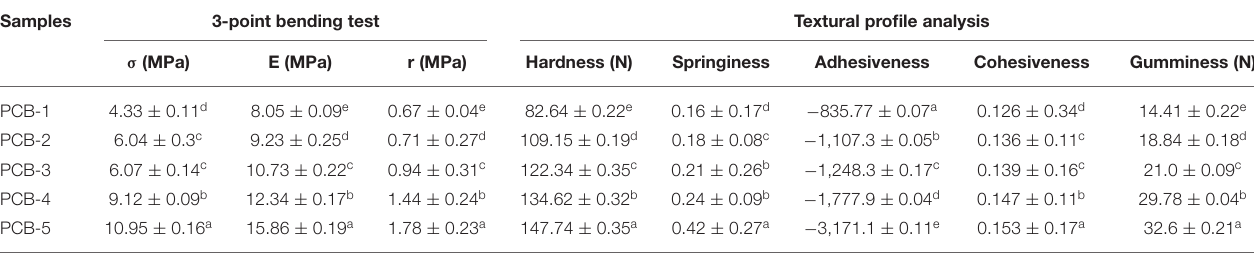
TABLE 5 | Textural characteristics of developed PCB.